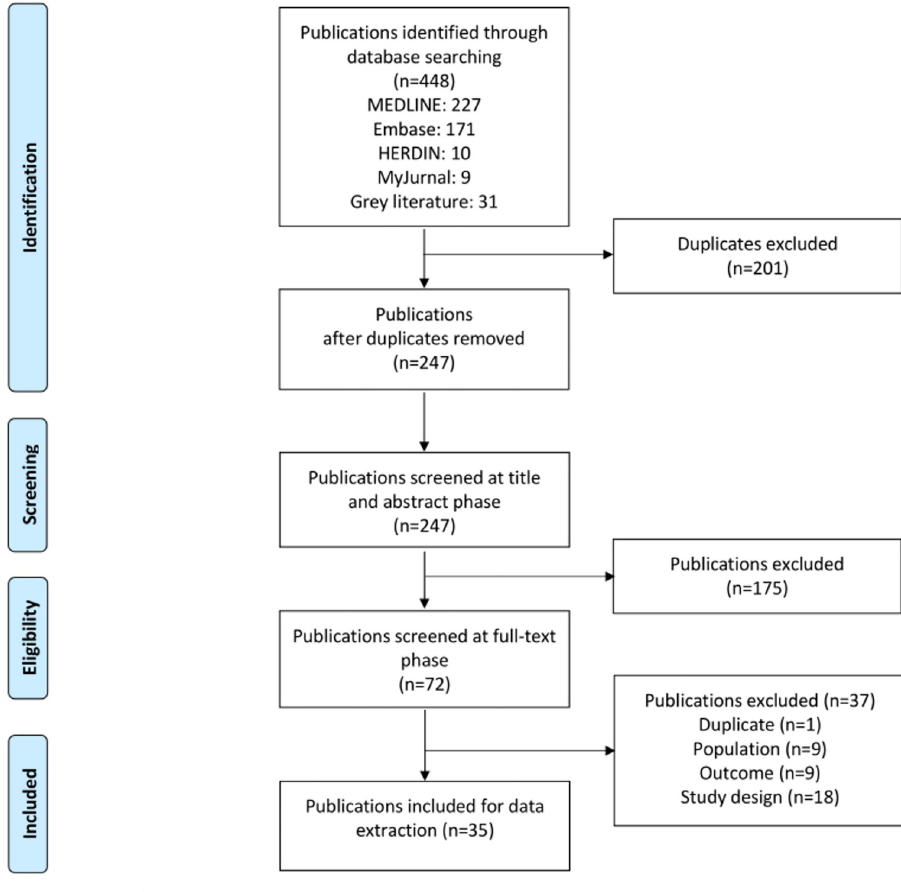
Fig 1. PRISMA flow